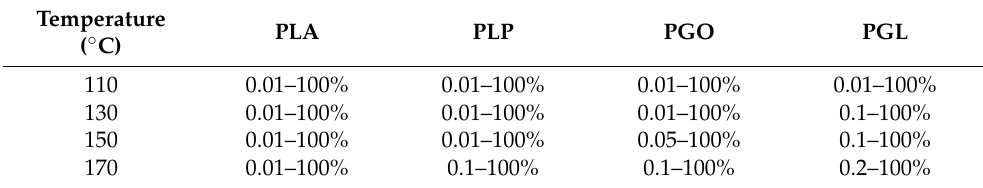
Figure 7. Determination of linear viscoelastic region (LVR) by the study of G’ ( a ) and G” ( b ) with strain for the PLA, PLP, PGO, and PGL at 170 ◦ C. Table 11. Linear viscoelastic region for PLA, PLP, PGO, and PGL at different